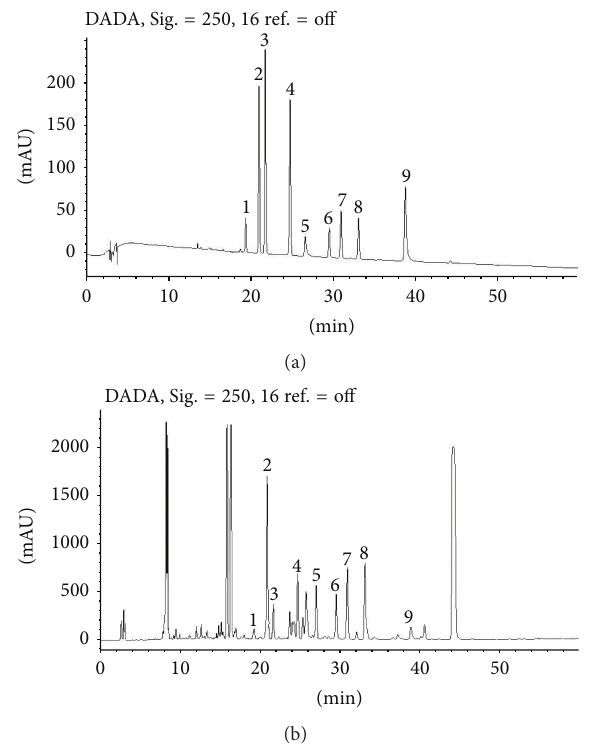
Figure 2: A chromatogram of mixture of standard compounds (a); a chromatogram of P. corylifolia L. from Jiangsu Province (b). Peak 1: isobavachin, peak 2: neobavaisoflavone, peak 3: